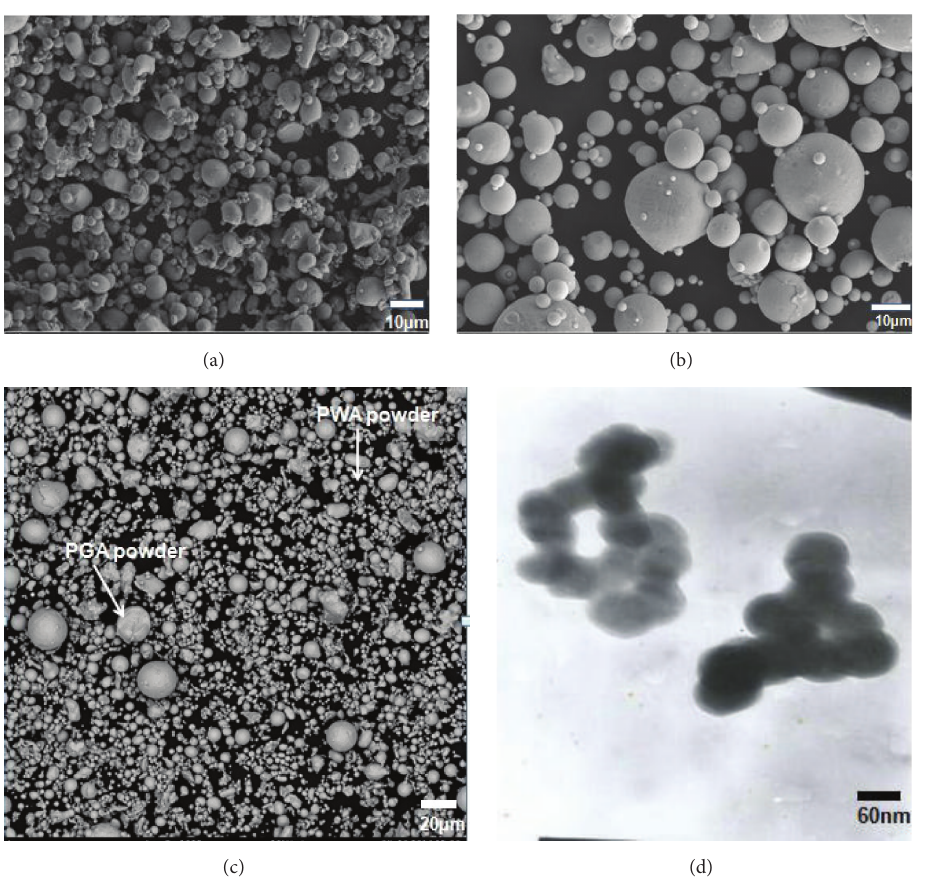
Figure 1: Raw materials for (a) PWA 316L SS and (b) PGA 316L SS and (c) P25/75 316L SS and (d) boron nanosized